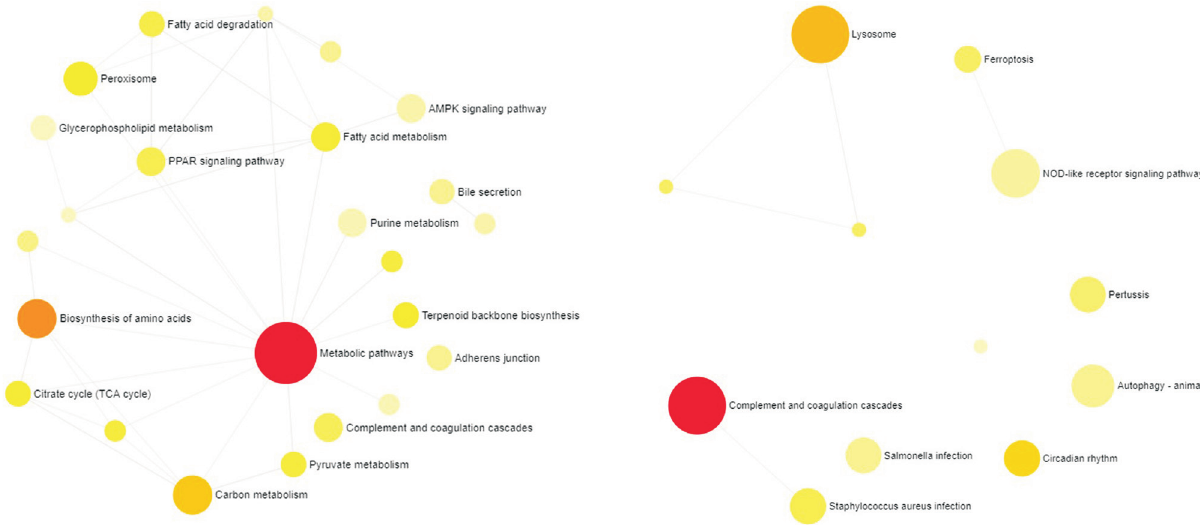
Figure 4 - Functional representation based on KEGG pathways for differentially expressed gene-sets in the Balbina (right side) and Brumado (left side) populations.